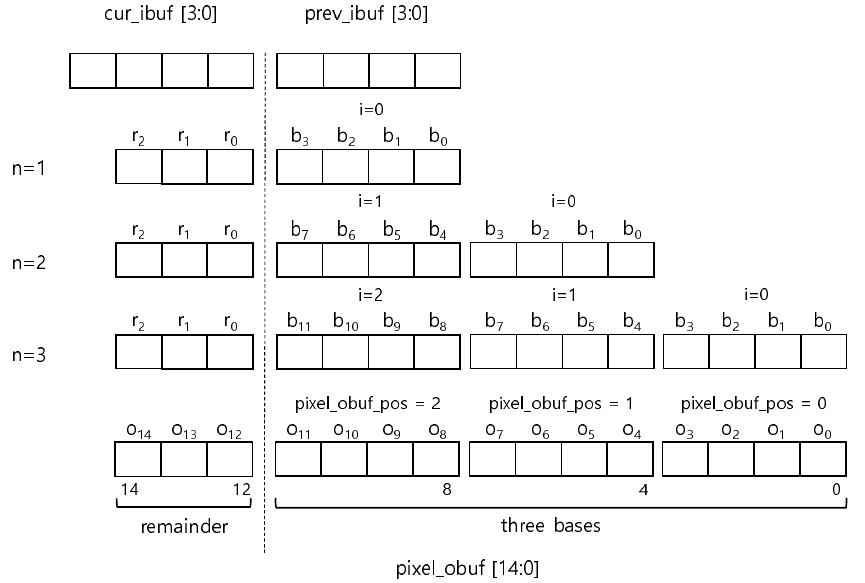
Figure 6. An output pixel buffer, pixel_obuf aligning with the cur_ibuf and the prev_ibuf buffers and showing the base positions depending on n